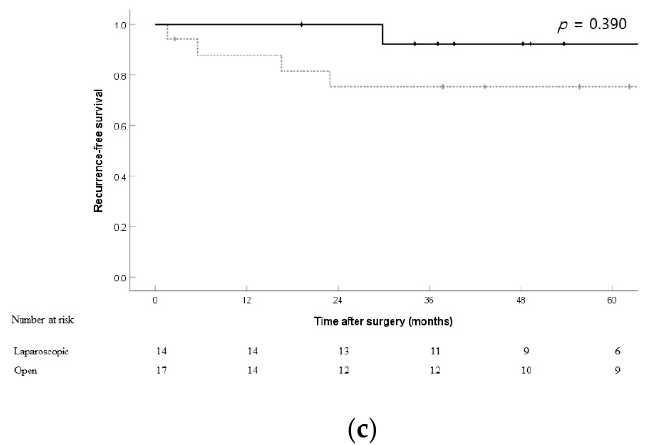
Figure 3. Recurrence-free survival between the laparoscopic and open groups in the overall cohort ( n = 44) ( a ), T2 patients ( n = 28) ( b ), and N0 patients ( n = 31) ( c ).